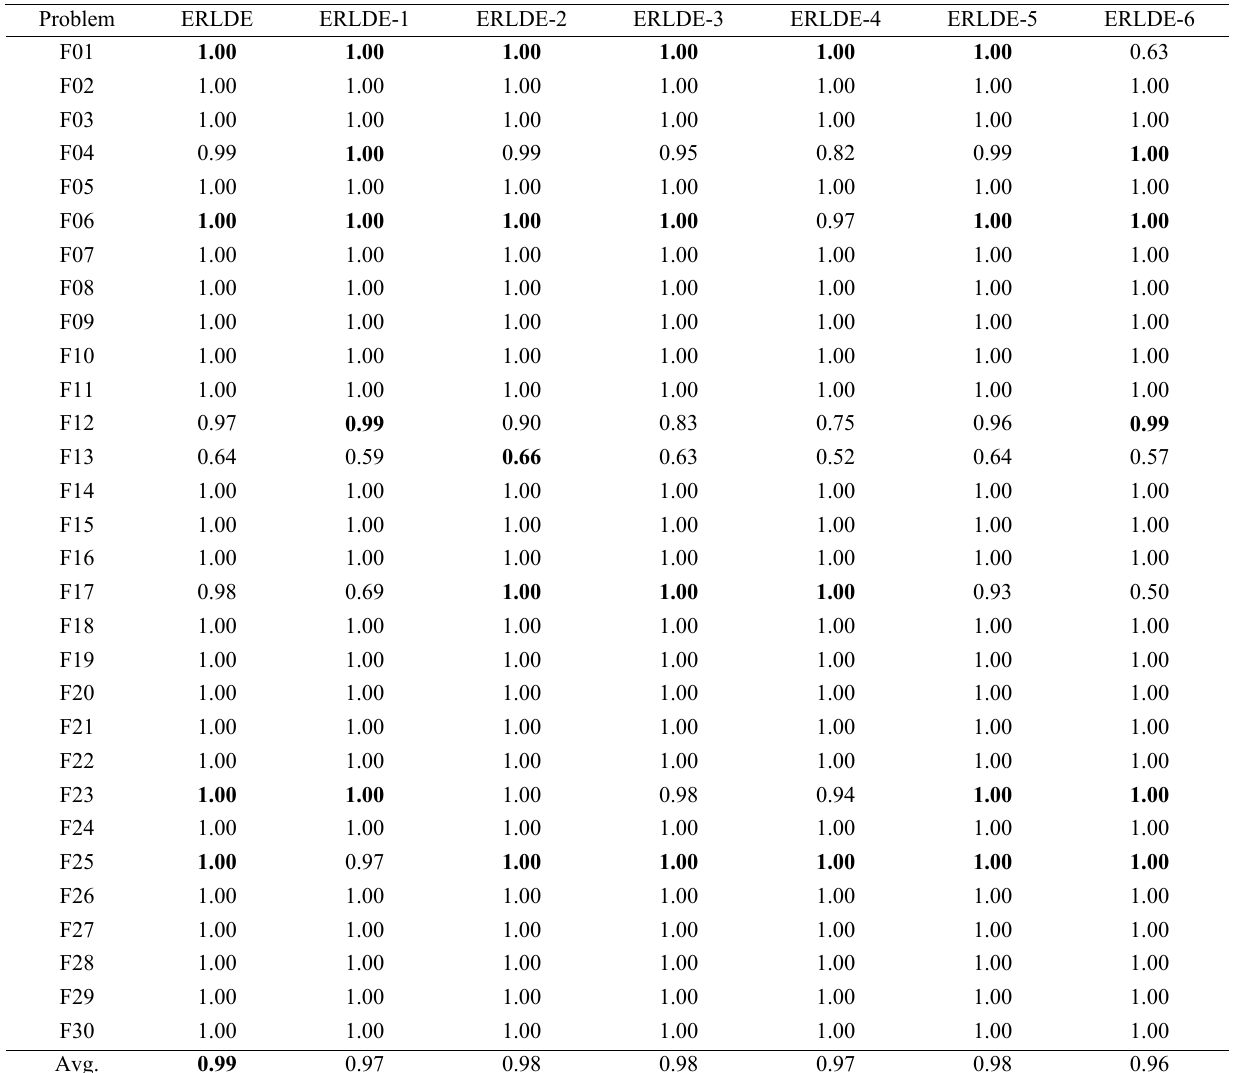
Table A4 Comparison between ERLDE and other ERLDE variants with respect to RR .